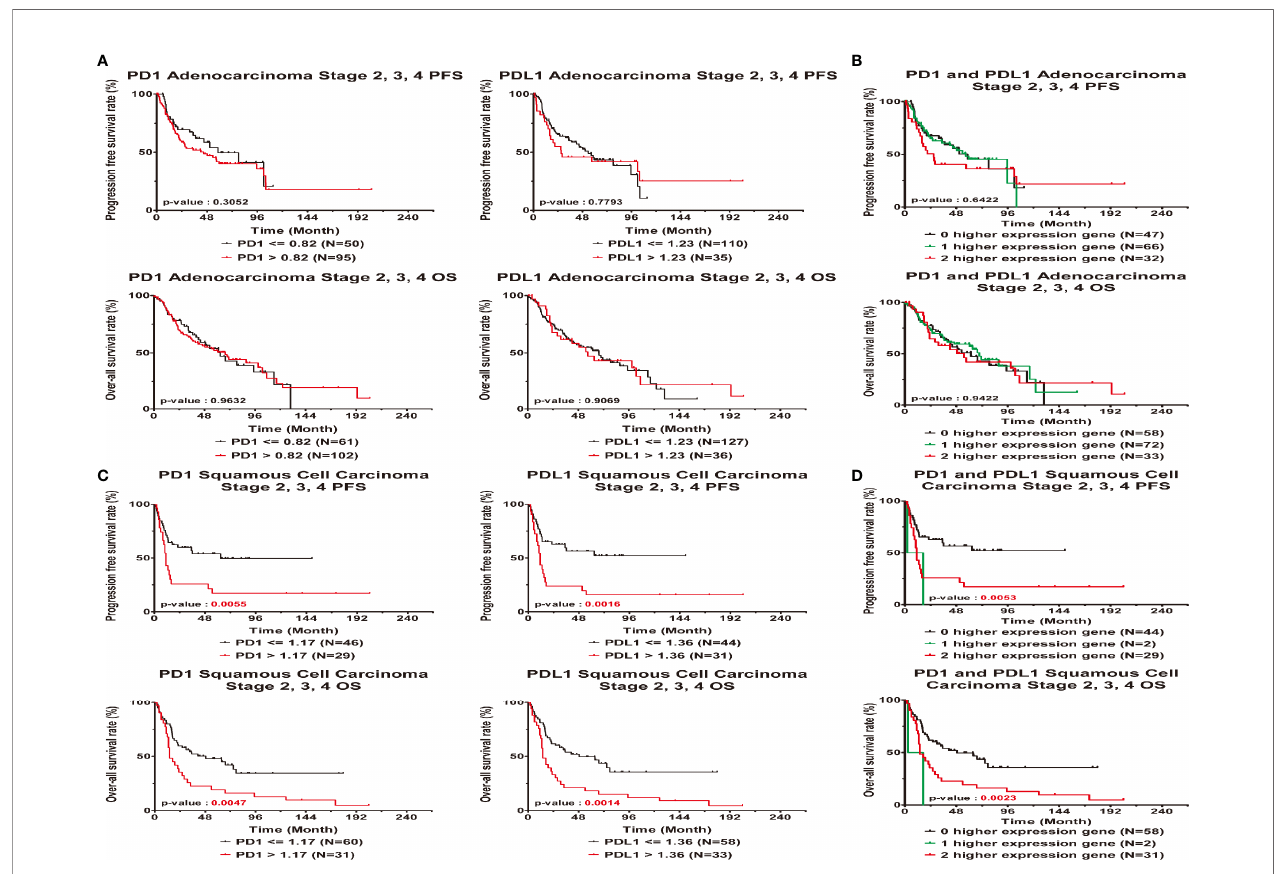
FIGURE 3 | Clinical outcome interacted with expression levels of PD1 or PDL1 in late stage lung cancer patients. Kaplan-Meier statistical analyses were conducted to examine the association between progression-free survival (top), over-all survival (bottom) and the expression of PD1 and PDL1 in adenocarcinoma (A) , squamous cell carcinoma (C) , the number of higher expressed genes (B, D) in all patients.